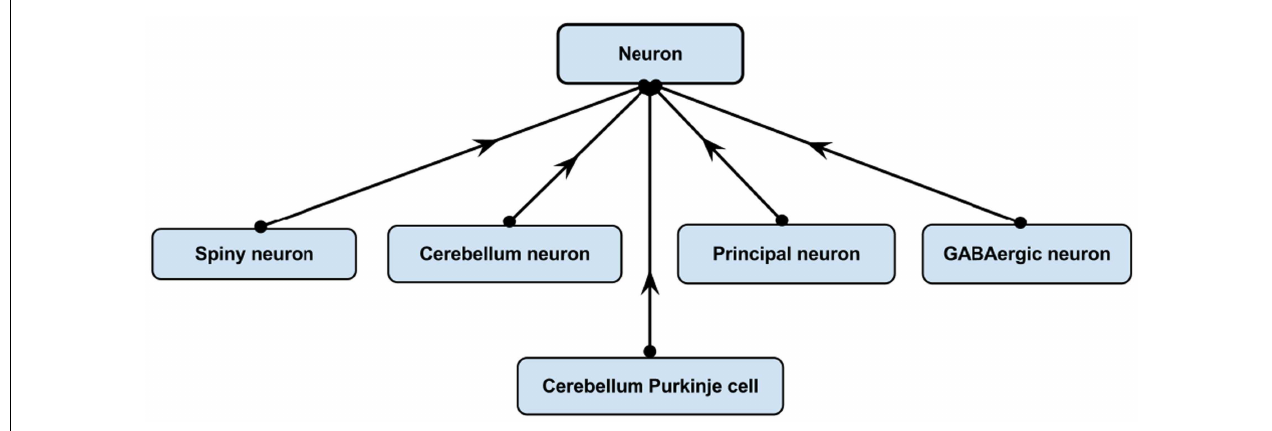
FIGURE 4 |Asserted simple hierarchy of “Cerebellum Purkinje